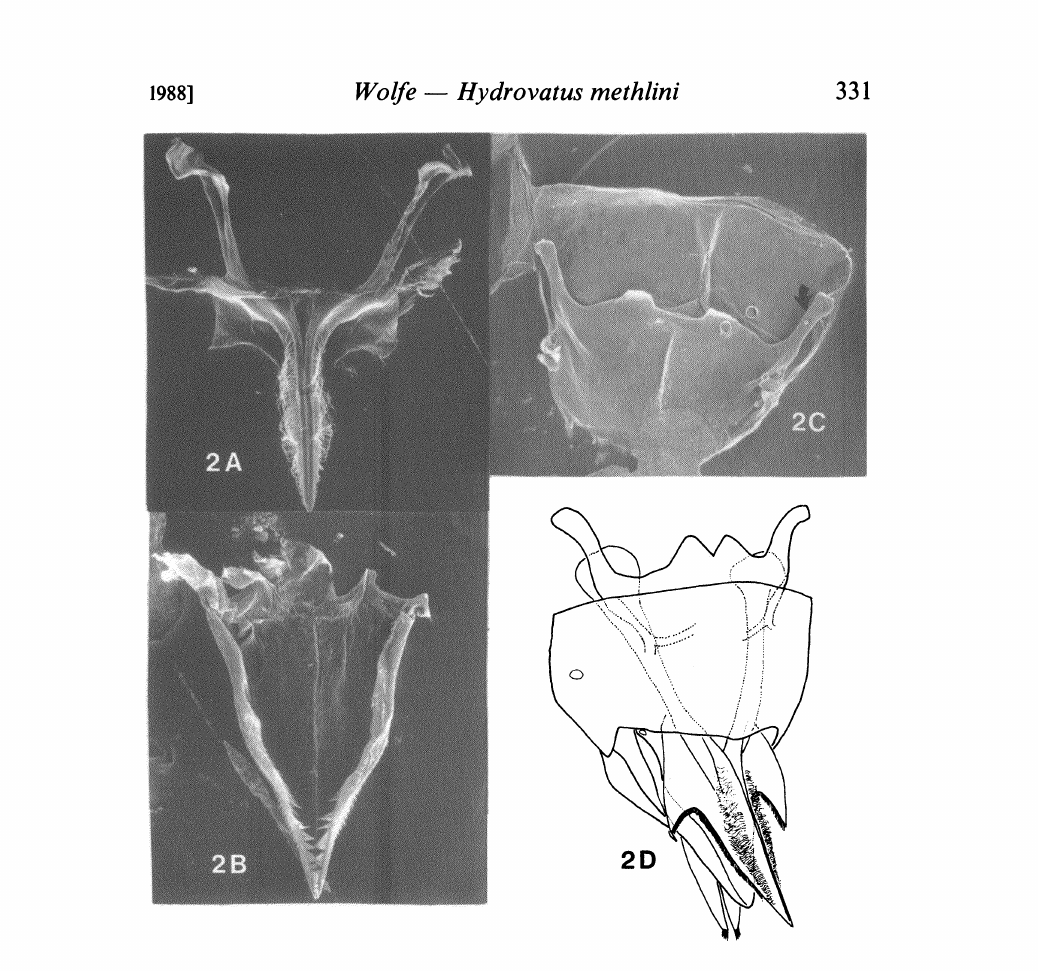
Figure 2. Abdominal structure of C. hubelli (60X) A) Acute, pointed, spear- shaped dorsal lamina of tergite 8. B) Ventral lamina. C) Ventral view of terga 6 and 7 showing apodemes on tergum 7. D) Composite illustration of terga 7 and